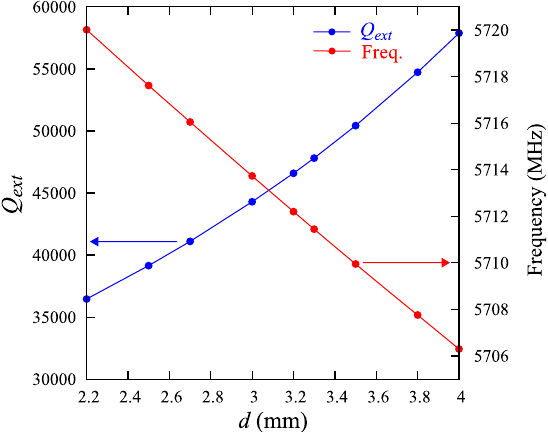
FIG. 9. Dependence of the resonant frequency f 0 (red dot line) and the external Q factor Q (blue dot line) of the DAA structure ext on the groove depth d . The radius of coupling slot r is 9.8 c